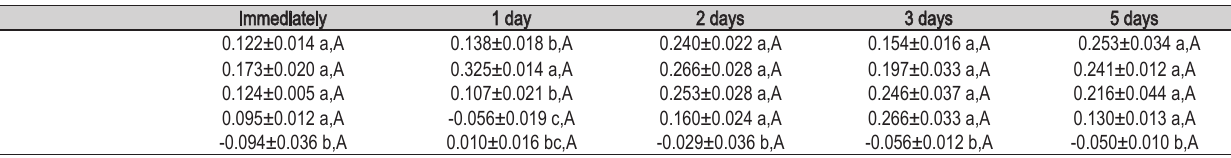
Table 2 - Mean of dimensional alteration and SD (%) of stone casts obtained with different alginates and poured in different periods of time (distance 33-43).